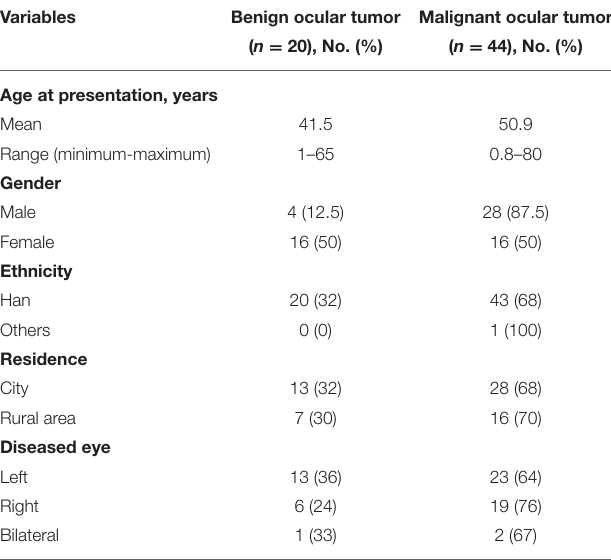
TABLE 2 | Demographics of donors with ocular tumors.